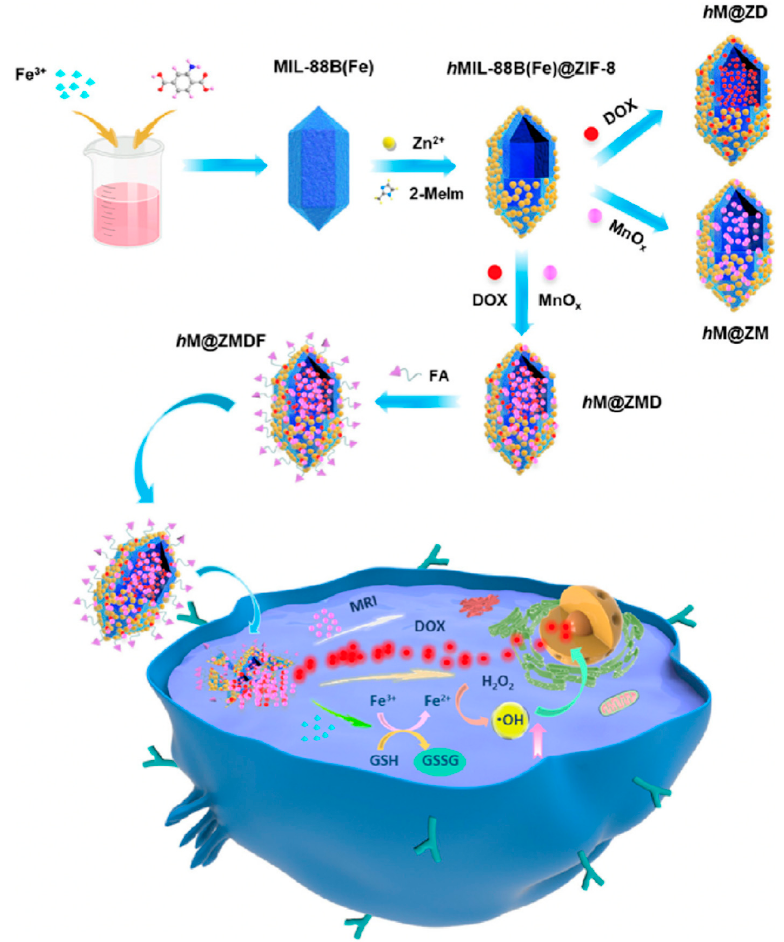
Figure 8. Schematic fabrication routes of hM@ZMDF nanoplatforms based on MIL-88B(Fe) and their applications in cancer-targeted combined therapy. Reprinted with permission from Ref. [113]. Copyright 2019, American Chemical Society.